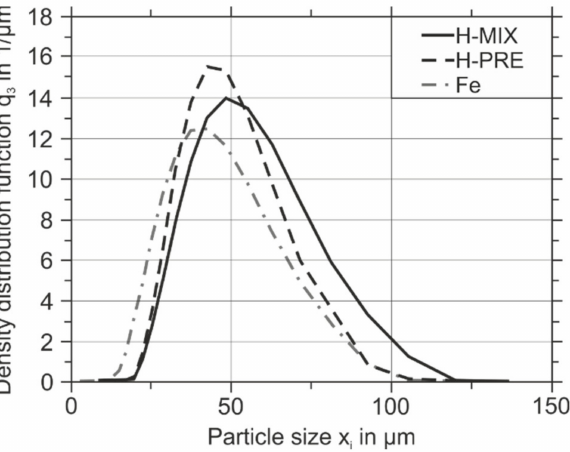
Figure 3. Particle size distributions of H-PRE, H-MIX, and Fe